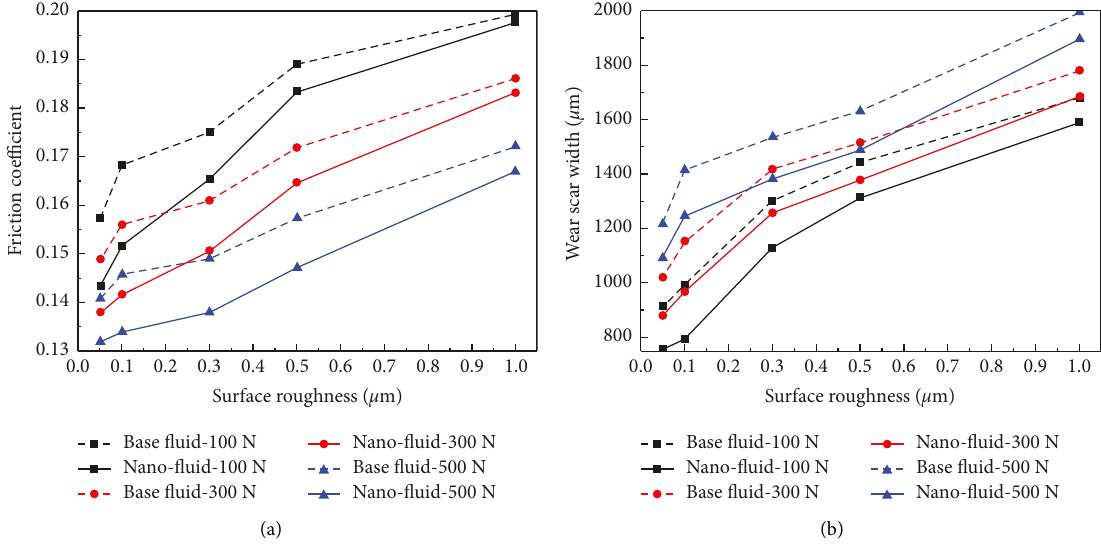
Figure 4: Variations of (a) friction coefficients and (b) wear scar widths with different surface roughness at various loads (300 rpm).